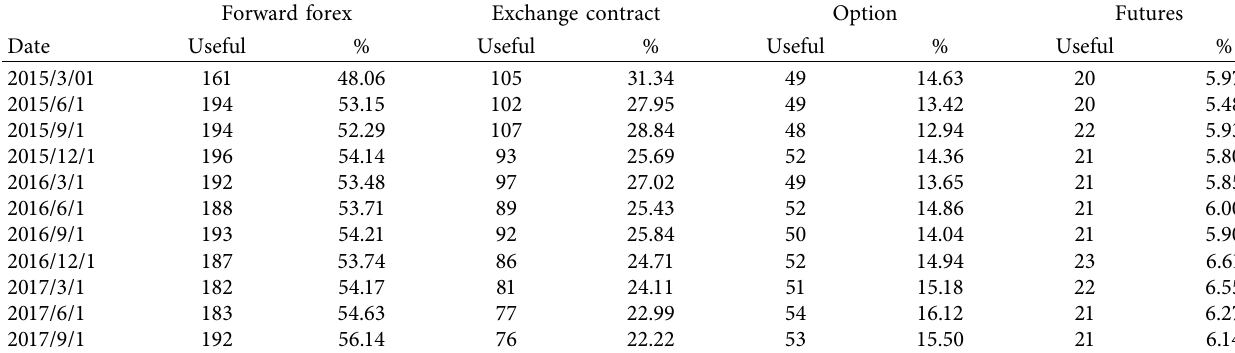
Table 4: Number of times of using derivative financial commodity